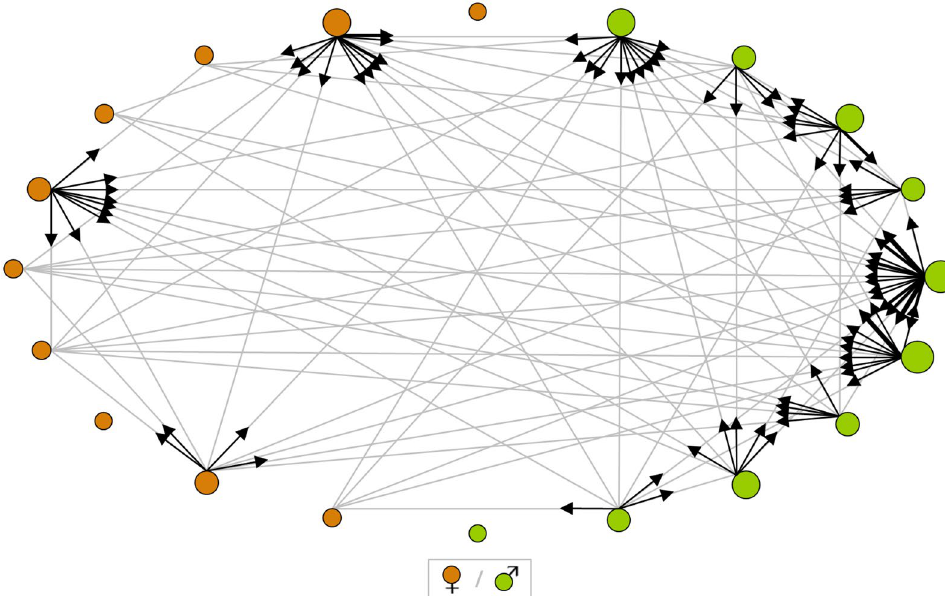
Figure 3. A social network showing the differences in cooperative tendencies between males and females in A. ergandros . The graph shows the foraging interactions in one exemplary group of ten males (green nodes) and ten females (brown nodes) recorded over ten repeated feeding trials. A line between two nodes indicates that one individual shared its prey with the other, the respective arrow specifies who acquired food for whom. The number of outgoing arrows per node reflects the food acquisition and sharing tendency of the particular individual in terms of spread over different group members. The node size reflects the frequency with which the individual acquired and shared prey over the duration of the feeding